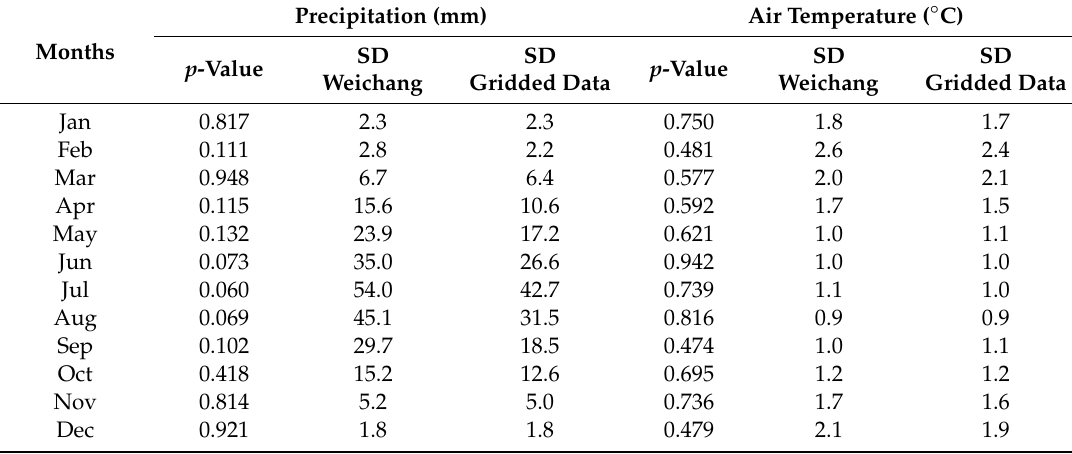
Table A1. Levene’s Test for homogeneity of variance for the gridded datasets and the data of Weichang meteorological station for the period 1951–2013. SD = Standard deviation. There is a significant relation if p > 0.05 α